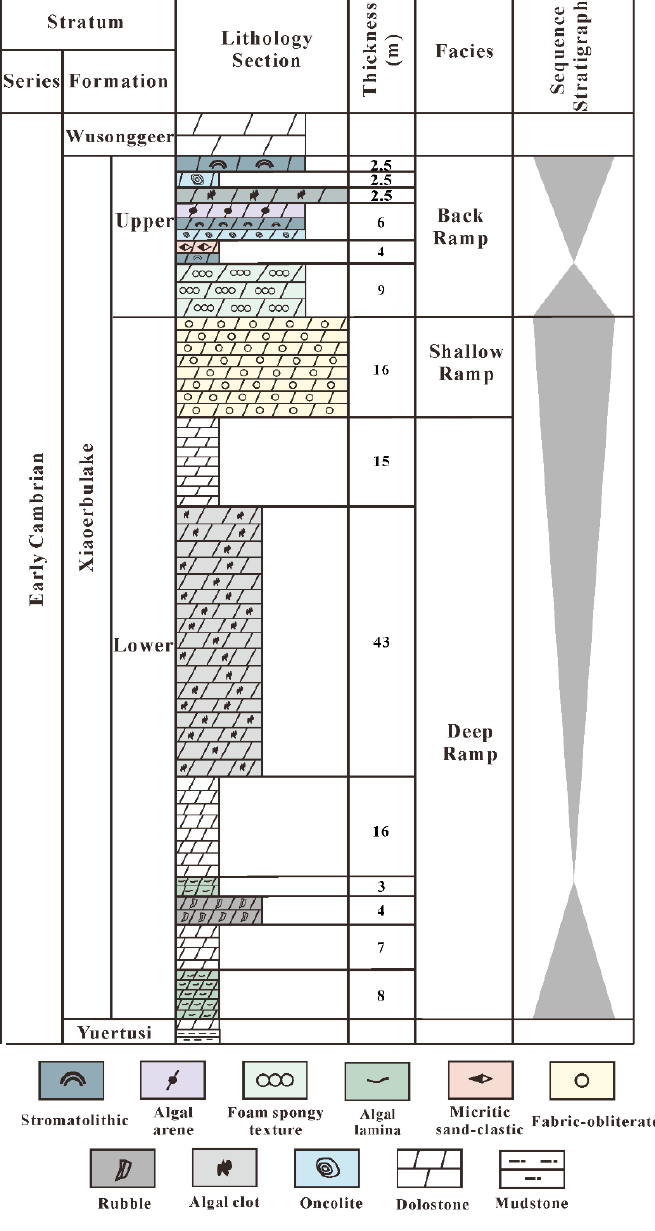
Figure 3. Simplified stratigraphic framework of the Early Cambrian from the Shihuiyao